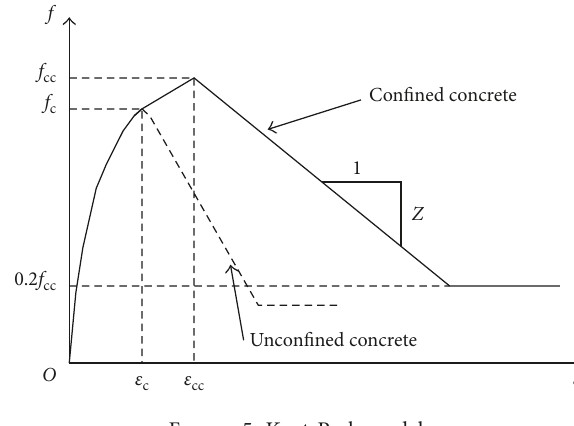
Figure 5: Kent-Park model.